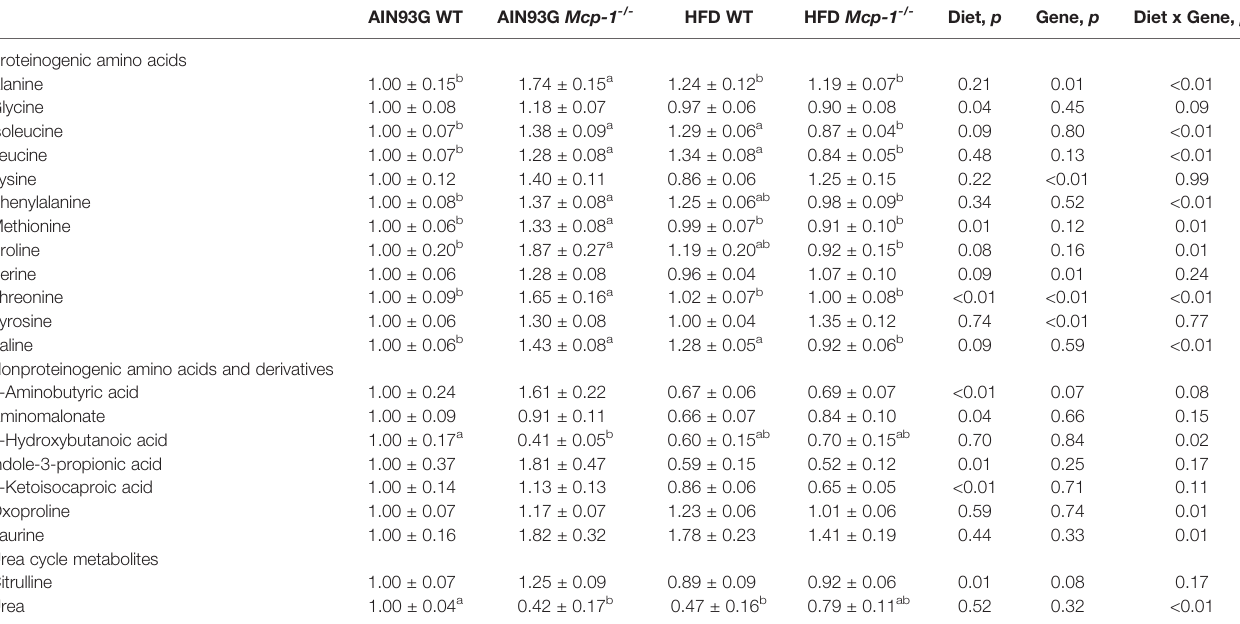
TABLE 2 | Identi fi ed plasma metabolites related to amino acid metabolism that differed in MMTV-PyMT mice with or without adipose monocyte chemotactic protein-1 knockout [ Mcp-1 -/- or wild-type (WT)] and fed the AIN93G or high-fat diet (HFD). AIN93G WT AIN93G Mcp-1 -/- HFD WT HFD Mcp-1 -/- Diet, p Gene, p Diet x Gene, p Proteinogenic amino acids Alanine